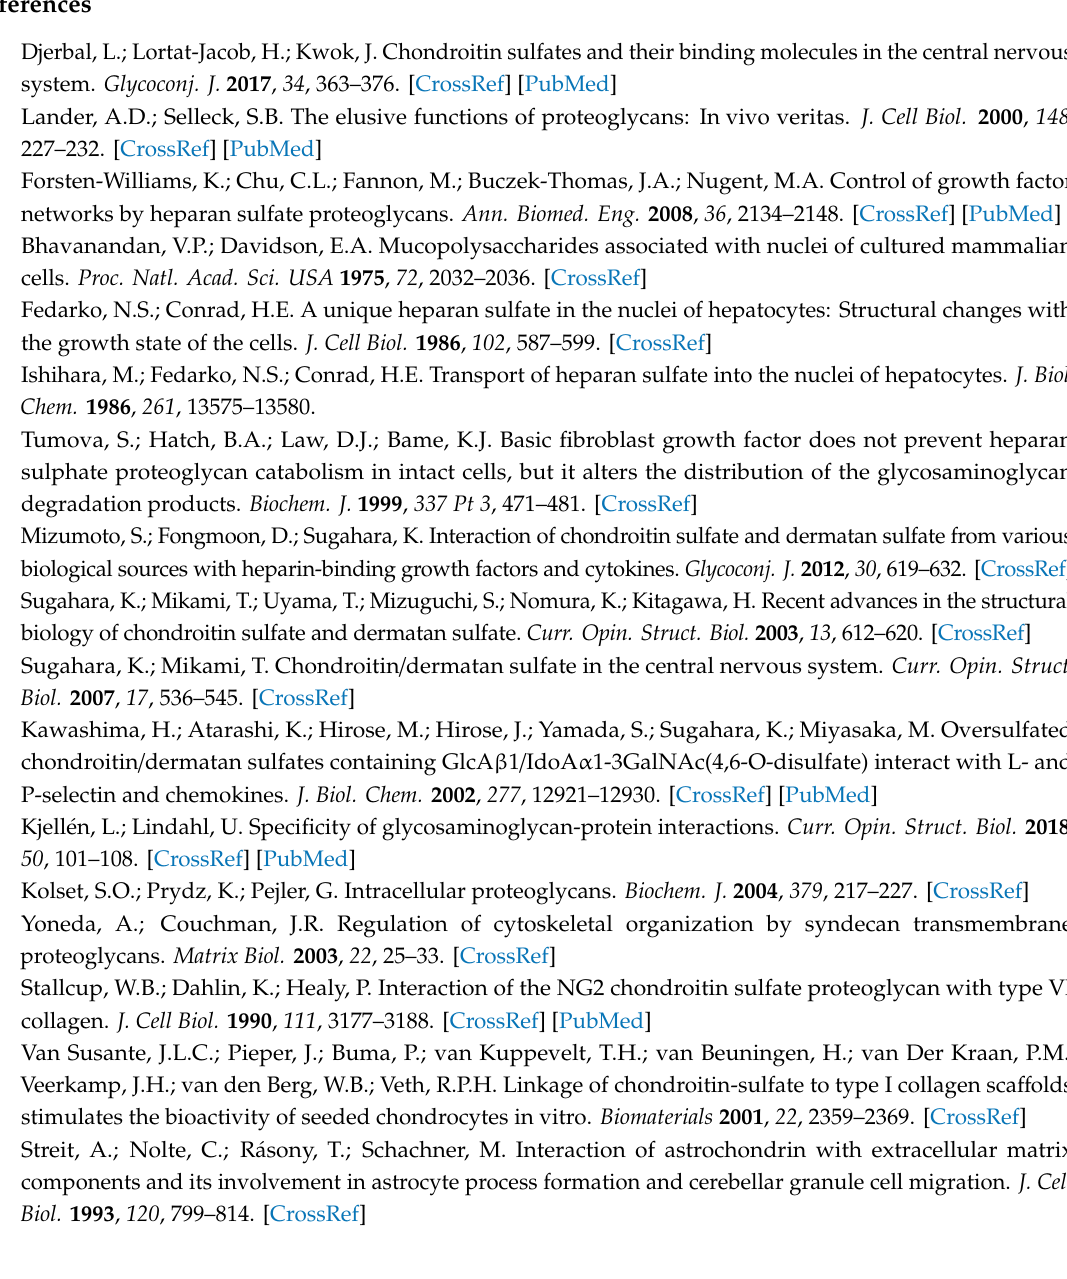
and GalNAc β 1-4GlcA glycosidic linkages in MD-generated non-sulfated chondroitin disaccharide ensembles and 20-mer ensembles constructed using glycosidic linkage dihedral probabilities from these MD-generated disaccharide ensembles, Figure S10: Bond energy distribution probability histograms from constructed 10-, 20-, 100-, and 200-mer ensembles, Figure S11: Average bond energies as a function of polymer